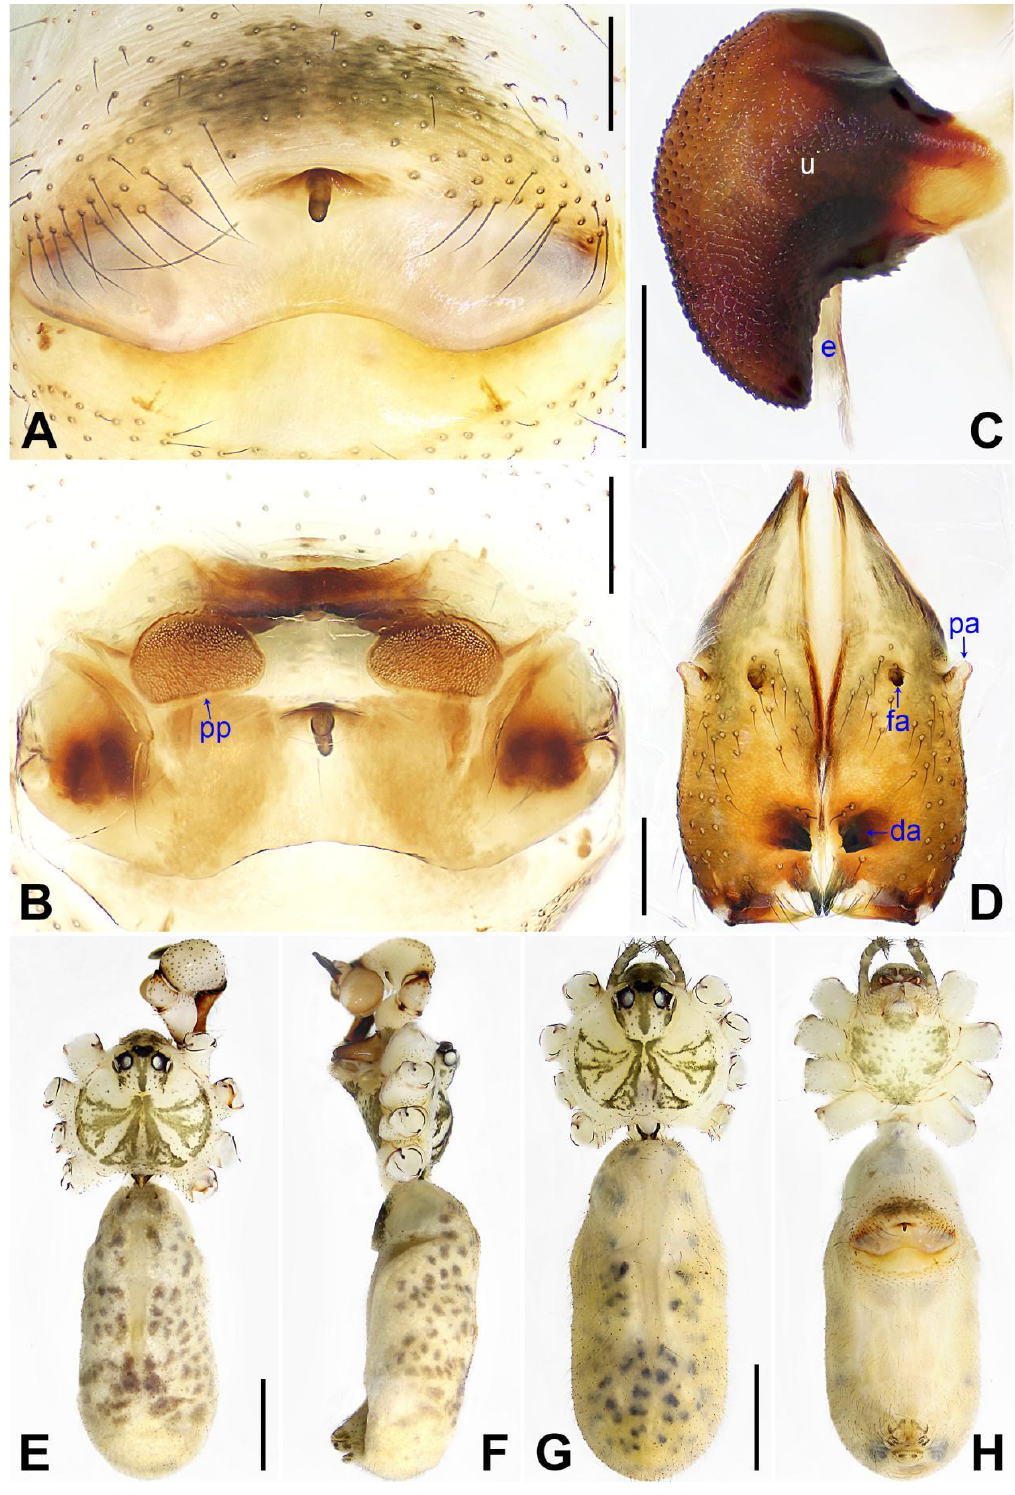
Figure 14. Pholcus xiangfen sp. nov., holotype male ( C – F ) and paratype female ( A , B , G , H ): ( A ) epigyne, ventral view; ( B ) vulva, dorsal view; ( C ) flipped right bulbal apophyses, prolateral view; ( D ) chelicerae, frontal view; ( E ), ( G ) habitus, dorsal view; ( F ) habitus, lateral view; ( H ) habitus, ventral view. da = distal apophysis, e = embolus, fa = frontal apophysis, pa = proximo–lateral apophysis, pp = pore plate, u = uncus. Scale bars: ( A – D ) = 0.20 mm; ( E – H ) = 1.00 mm.